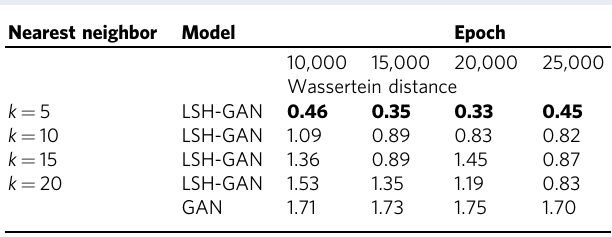
Model is trained on synthetic data of size 100×1000 Gaussian mixture data with two non- overlapping classes. The minimum distances are represented as bold face.